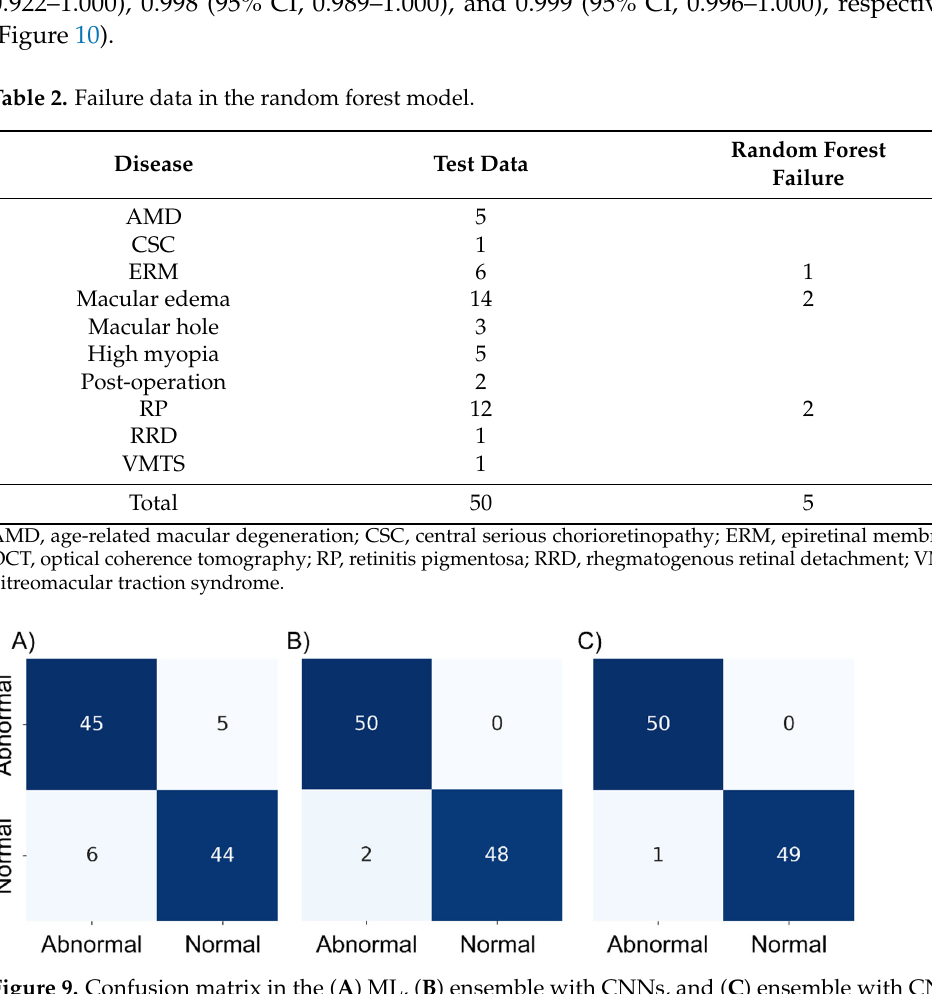
Figure 10. Diagnostic performances of the ML (purple), ensemble (blue), and ensemble with ML (red) models. The diagnostic performances of the ML, ensemble, and ensemble with ML models were 0.962 (95% CI, 0.922–1.000), 0.998 (95% CI, 0.989–1.000), and 0.999 (95% CI, 0.996–1.000), re ‐ spectively. The diagnostic performance was significantly greater in the ensemble model with ML than in both ML and ensemble models ( p < 0.001). Abbreviations: ML, machine learning; CI, confi ‐ dence interval.